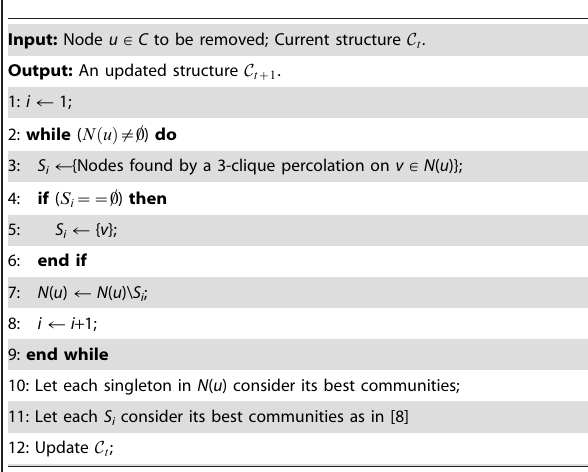
Table 3. Algorithm 3.